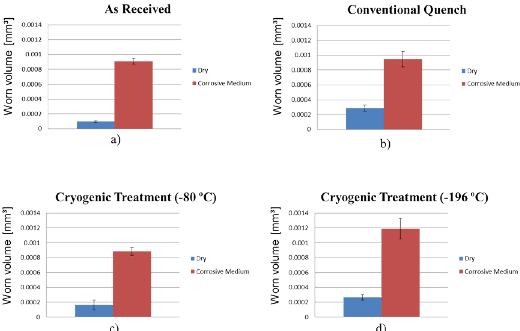
Figure 9: Worn volume loss for tests in dry condition and in presence of corrosive medium for all the conditions: a) As received, b) conventional quenching, c) cryogenic quenching (-80 °C), d) cryogenic quenching (-196 °C).